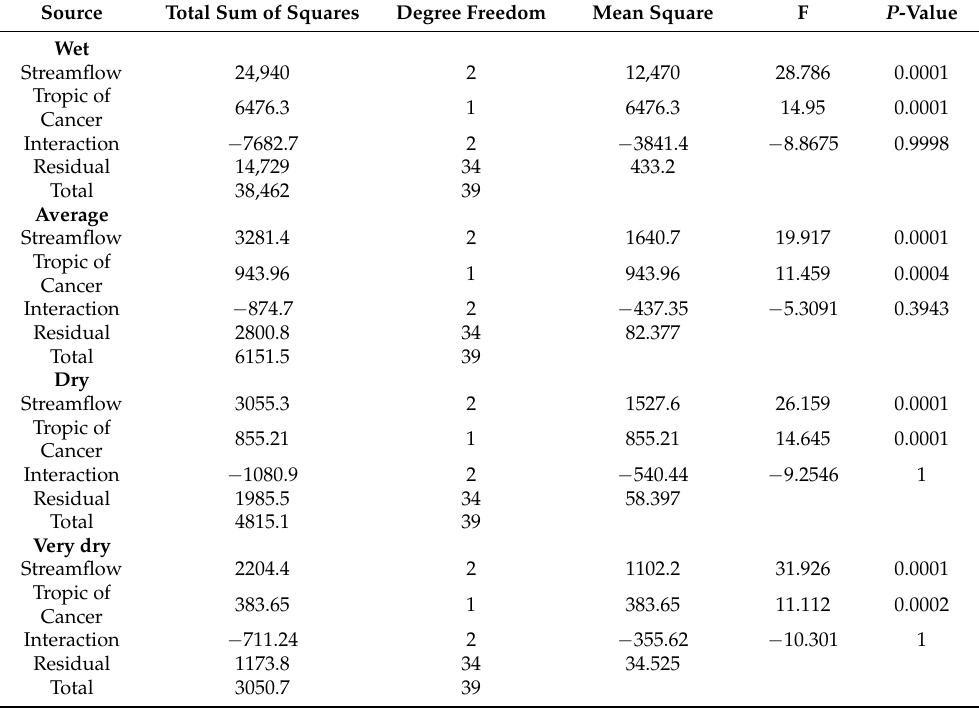
Table A5. Pairwise test of response variables between the groups of rivers based on the stream- flow and the Tropic of Cancer classifications (two-way PERMANOVA). Euclidean similarity index, permutation 9999